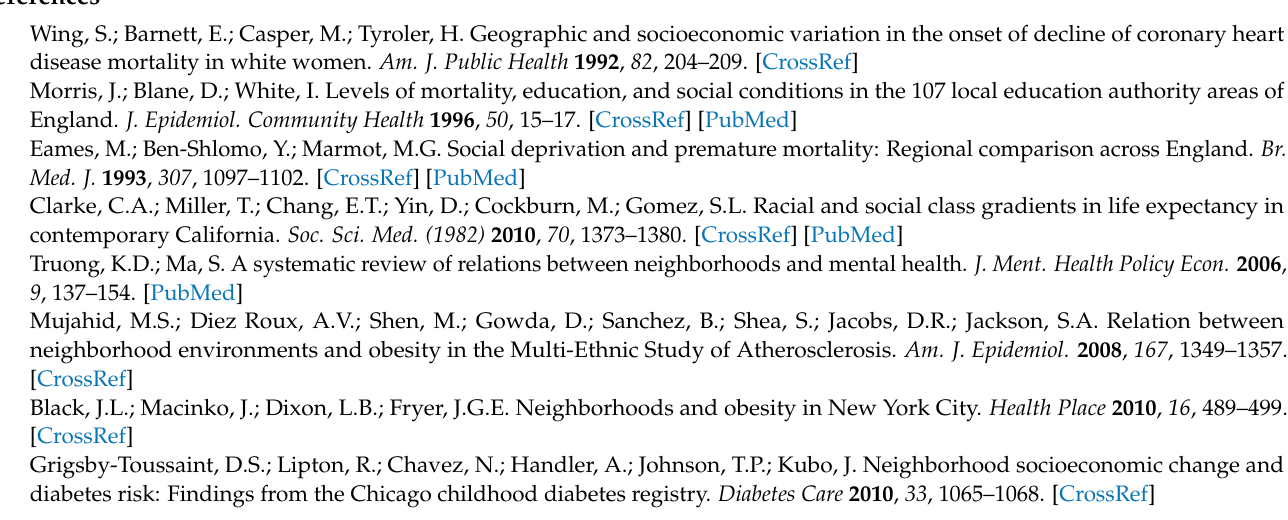
Table S2: Sociodemographic characteristics of the sample by race/ethnicity, Table S3: Associations between Google Street View-derived built environment characteristics and coronary artery disease, hypertension, and diabetes by race and